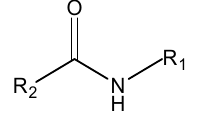
Figure 1. General structure of an alkylamide.